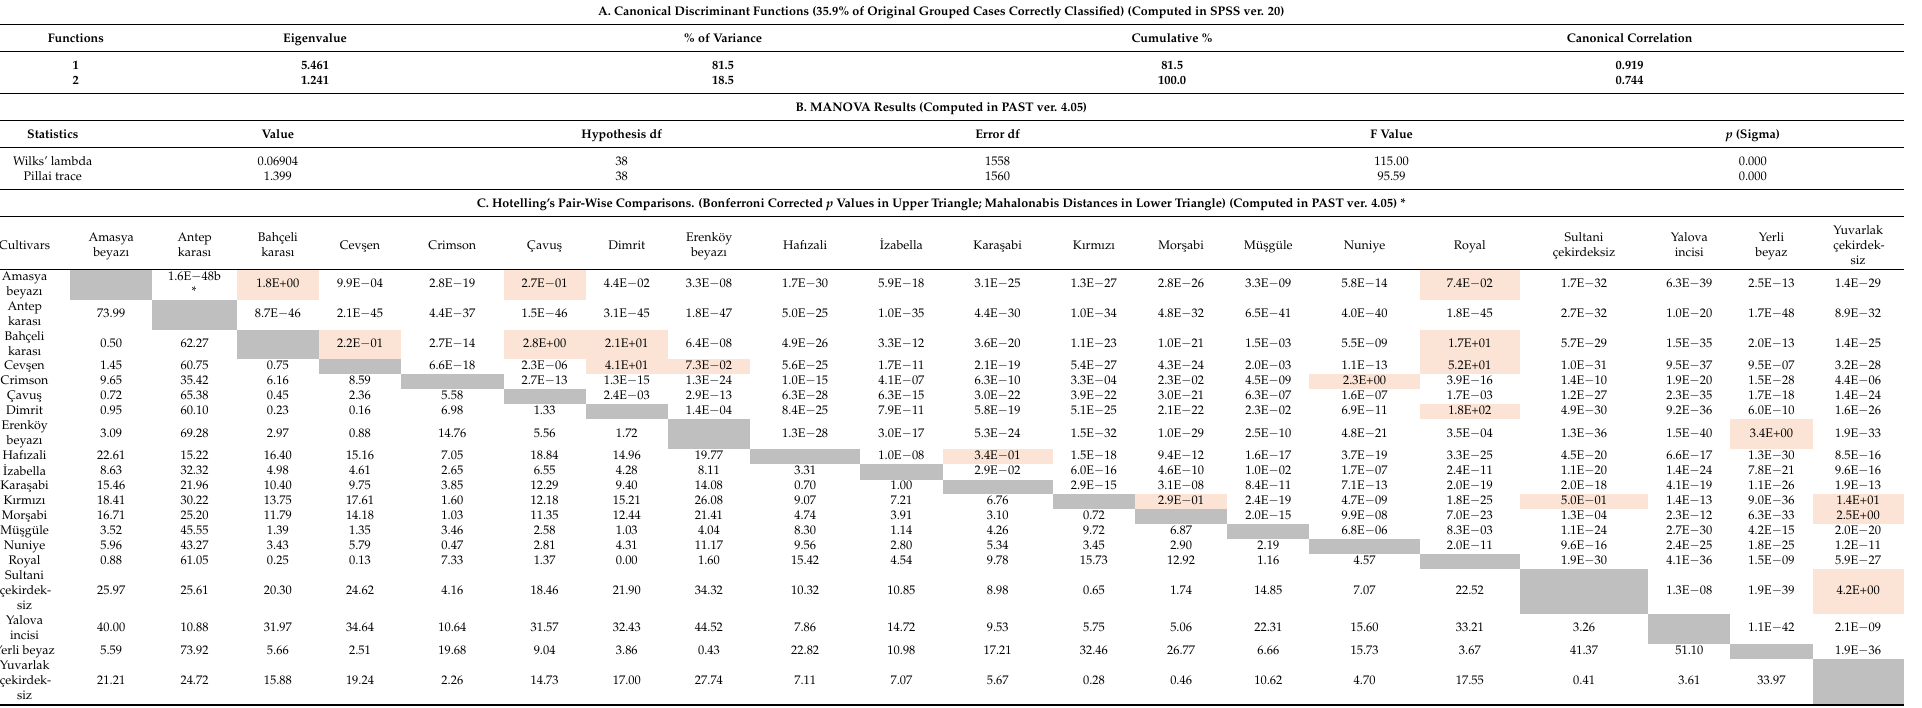
Table 6. The results of the discriminant analysis and pair-wise